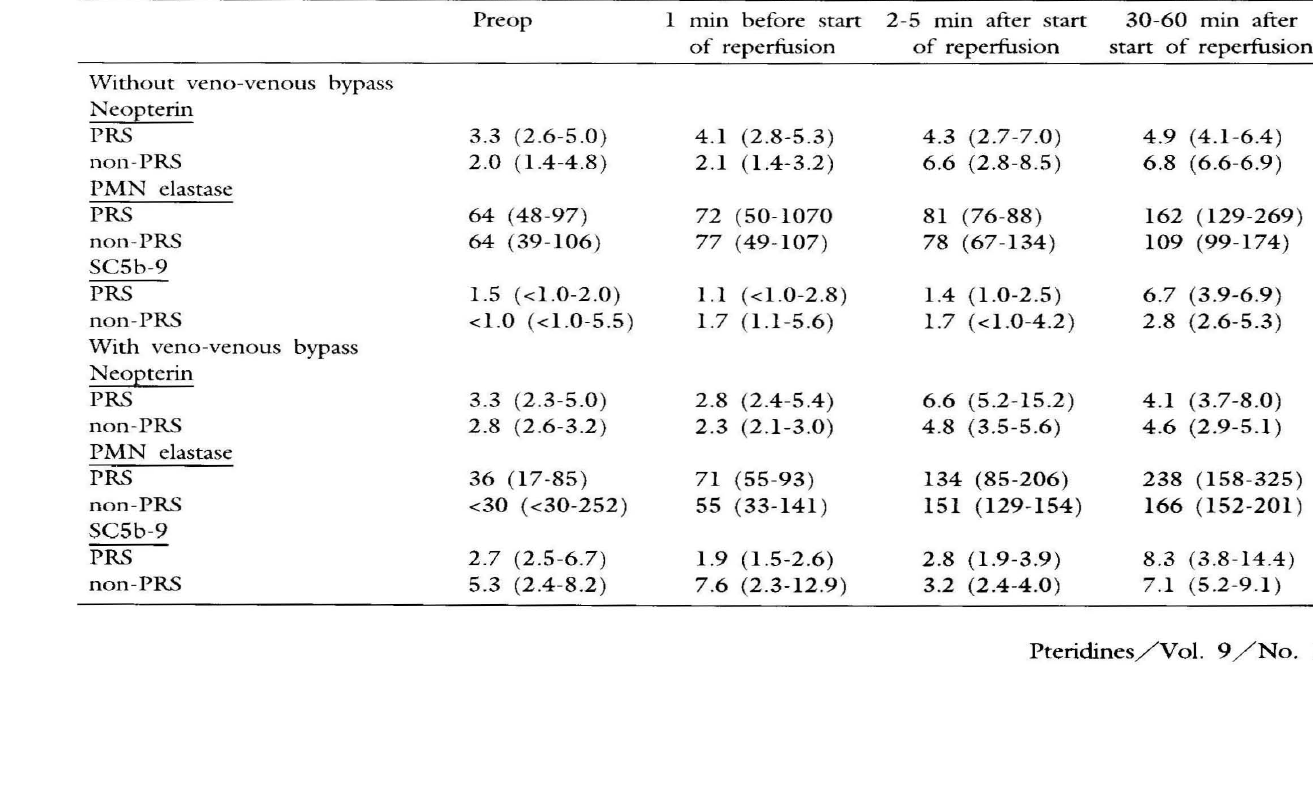
Table 1. Neopterin, PMN elastase and terminal complement complex (SC5b-9) in patients undergoing liver tran splantation operated upon with and without a veno-venous bypass. Mean values and 25th-75th percentiles are